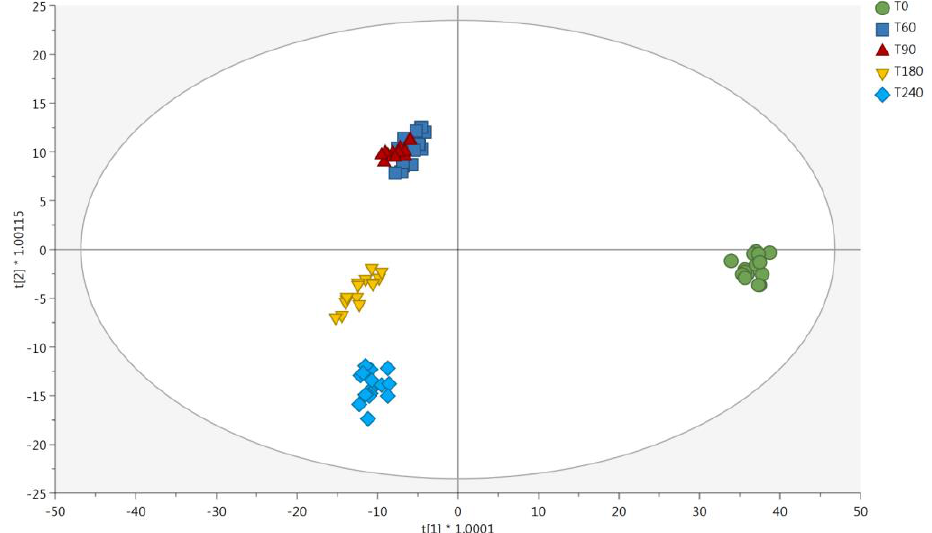
Figure 3. Score plot deriving from supervised orthogonal projection to latent structures discriminant analysis. The output was built considering the untargeted metabolomic profile of Coppa Piacentina PDO samples during ripening time (i.e., T0, T60, T90, T180, and T240 days). Abbreviations: first latent vector (t[1]); second latent vector (t[2]).